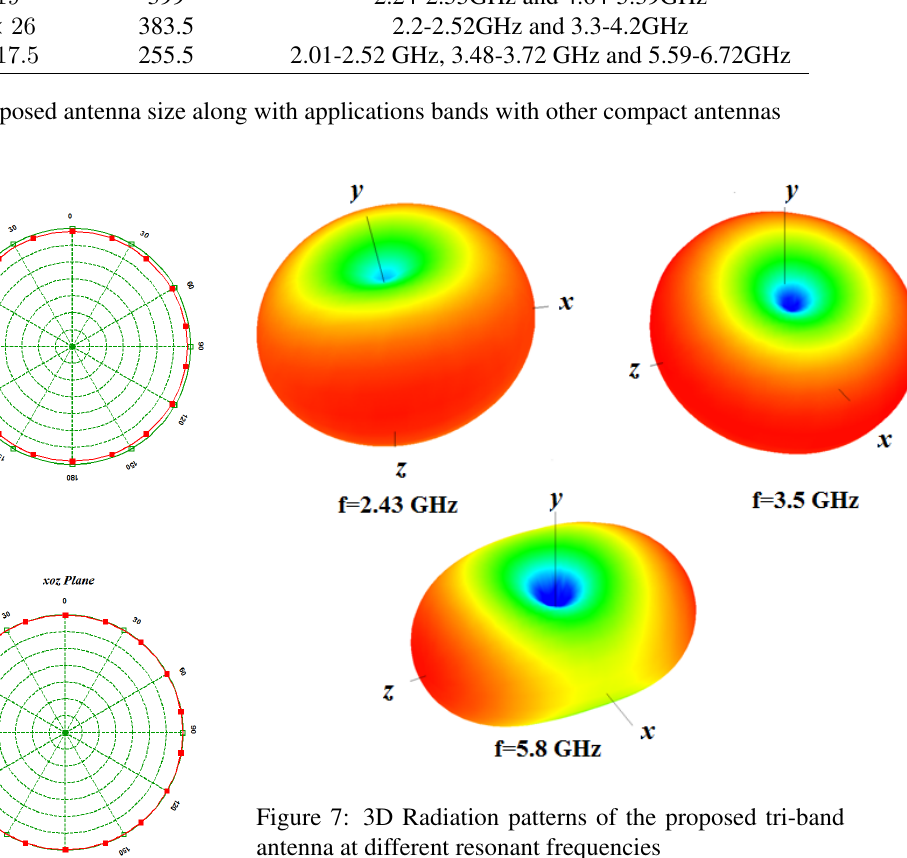
lated and measured results. Furthermore, due to the small size of the antenna the electrical size of the ground plane